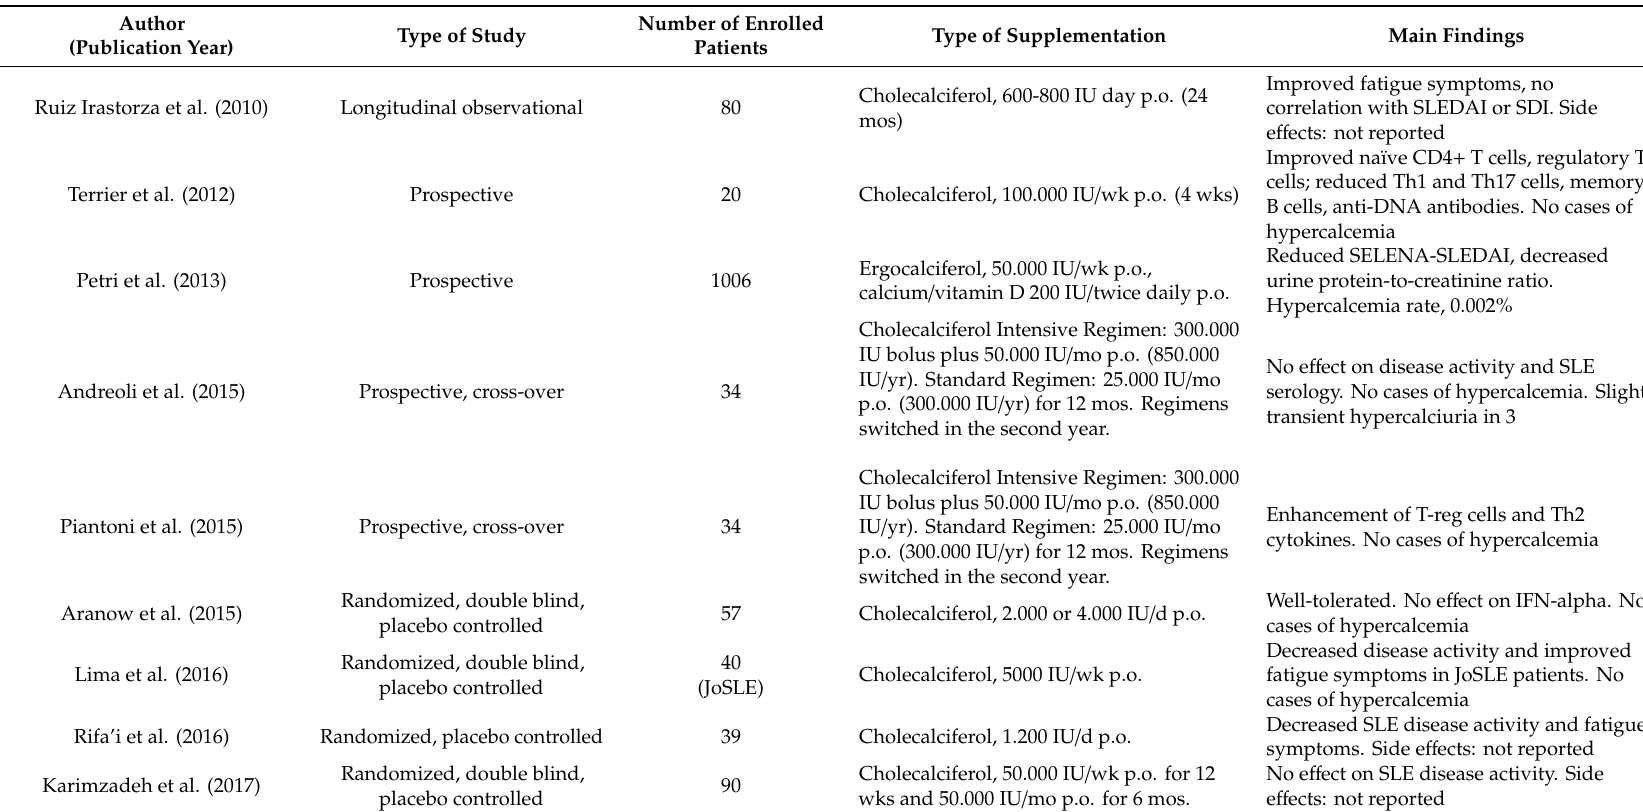
Table 1. Prospective studies on vitamin D e ff ects in systemic lupus erythematosus (SLE)